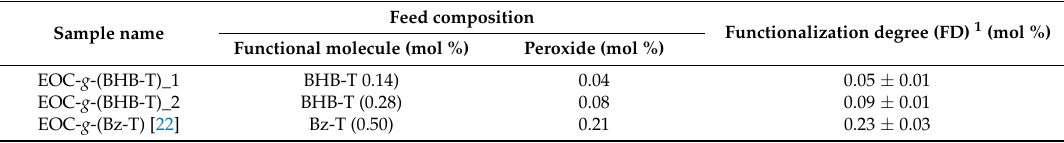
Table 1. Functionalized polymer samples: feed composition and functionalization